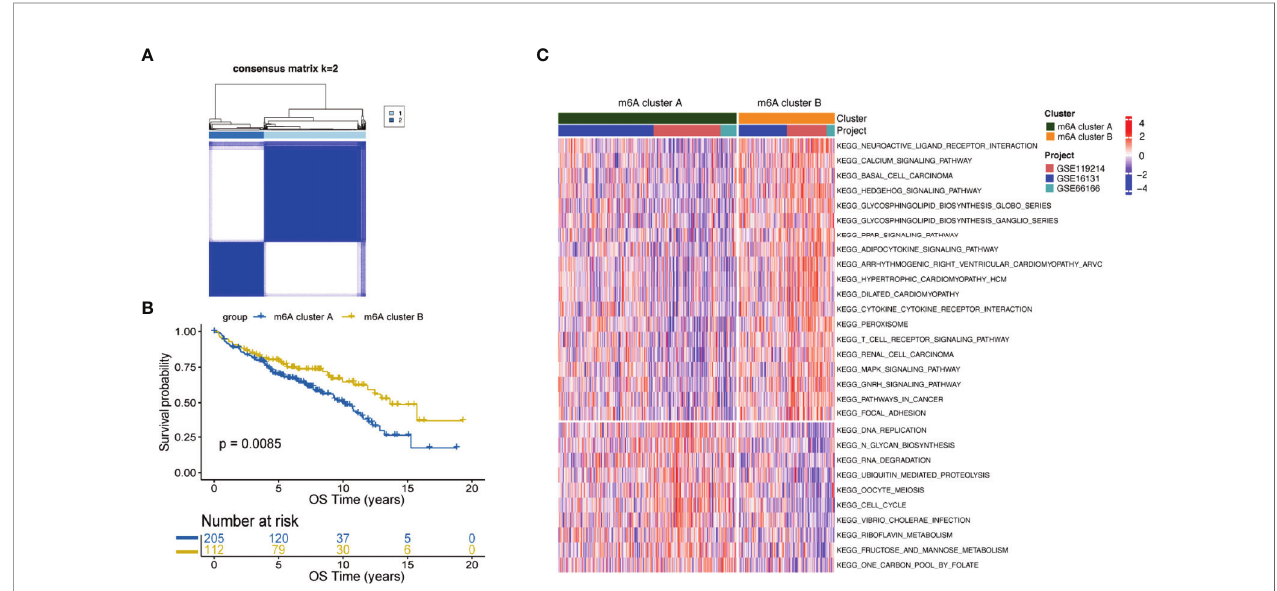
FIGURE 1 | m6A clusters mediated by m6A-regulators and the biological features of each cluster. (A) Unsupervised clustering based on m6A-regulator expression and consensus matrices for k = 2. (B) Survival analysis between m6A clusters by the log-rank test. (C) GSVA showing the activation status of biological pathways in m6A cluster A vs. m6A cluster B. An adjusted p-value<0.05 was considered signi fi cantly signi fi cant. Biological pathways with adjusted p<0.05 and p<0.0001 were shown in the fi